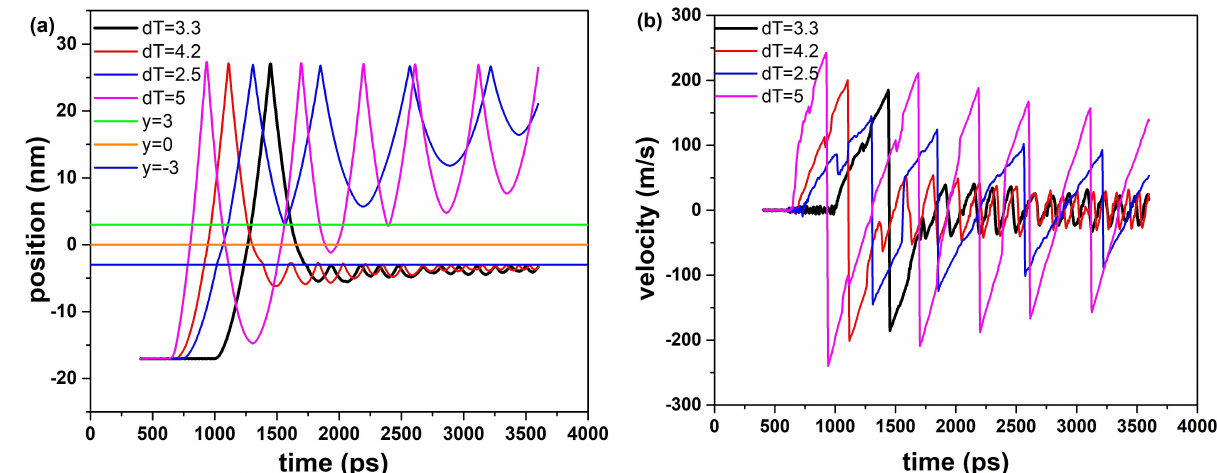
Figure 15: Variation of the movement behaviors with time for the temperature gradient of the system is 3.3K/nm, 4.3K/nm,5K/nm and 2.5K/nm respectively: (a) The position with time. (b) The velocity with